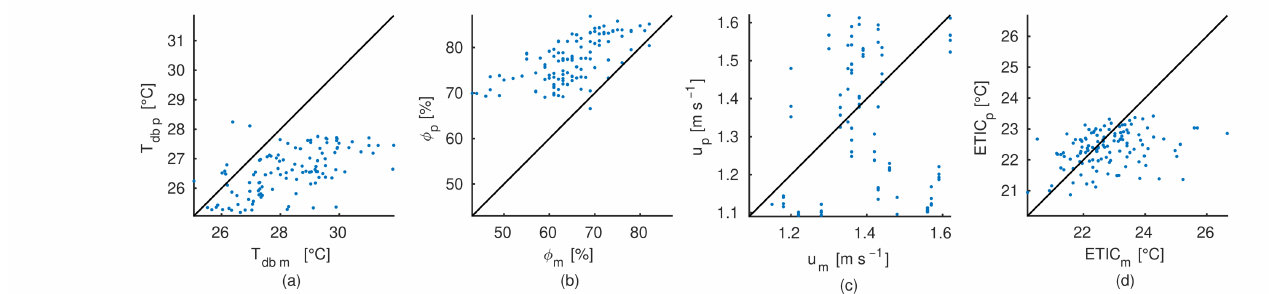
Figure 8. Regression analysis of the experimental measurements ( m ) and CFD predicted ( p ) conditions inside the tunnel-ventilated compost packed dairy barn using the CFD model developed. ( a )—Dry- bulb temperature ( T db [ ◦ C ]). ( b )—Relative humidity ( φ [%]). ( c )—Airflow velocity ( u [m s − 1 ]). Solid black line corresponds to the equality line. ( d )—Equivalent Temperature Index for dairy Cattle (ETIC [ ◦ C]). Solid black line corresponds to the equality